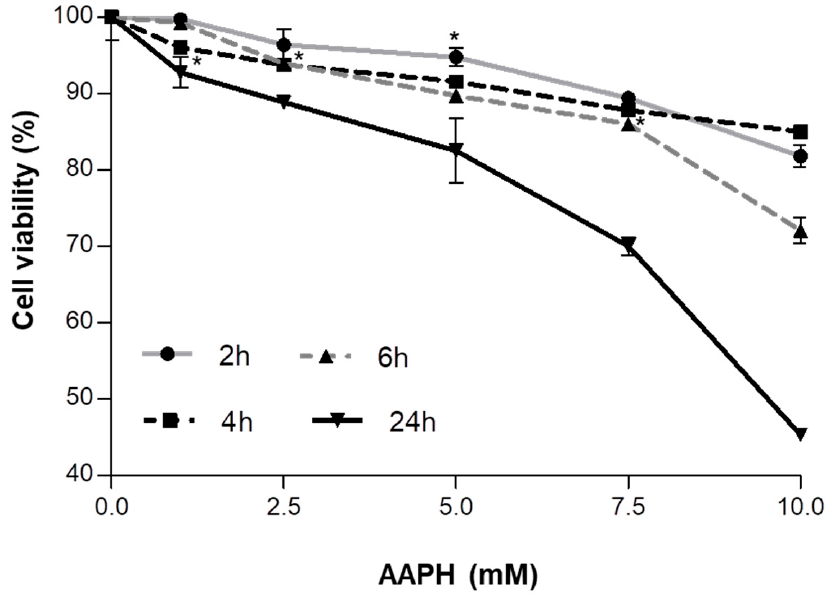
Figure 1. Viability of HepG2 determined by the MTT assay. Cells were incubated with different concentrations of AAPH (0–10 mM) at the indicated times. Values are expressed as the mean ± SD of three independent experiments ( n = 3). * Indicates the concentrations from which significant differences ( p < 0.05) were observed compared to the control.